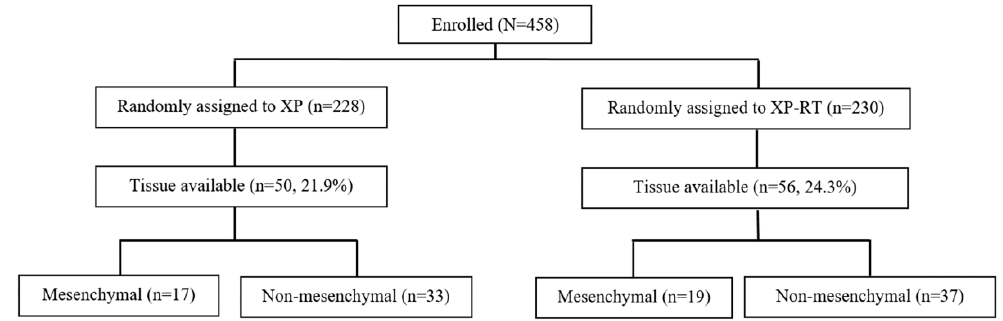
Figure 1. Flow diagram of patient inclusion.